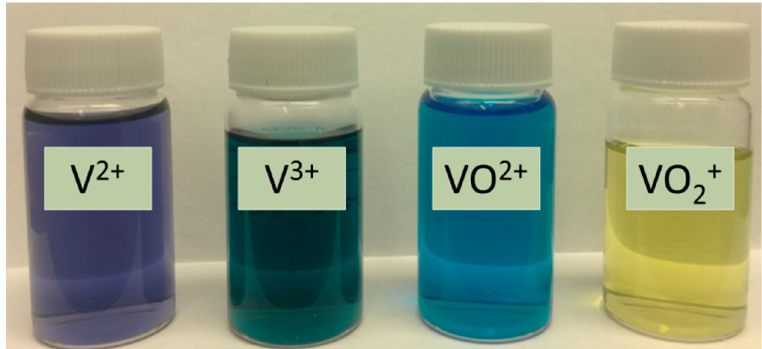
Figure 20. Photograph showing colors of 0.1 M vanadium sulfate solutions in 2 M H 2 SO 4 observed after completing charging (V 2+ and VO 2+ ) and discharging (V 3+ and VO 2+ ).